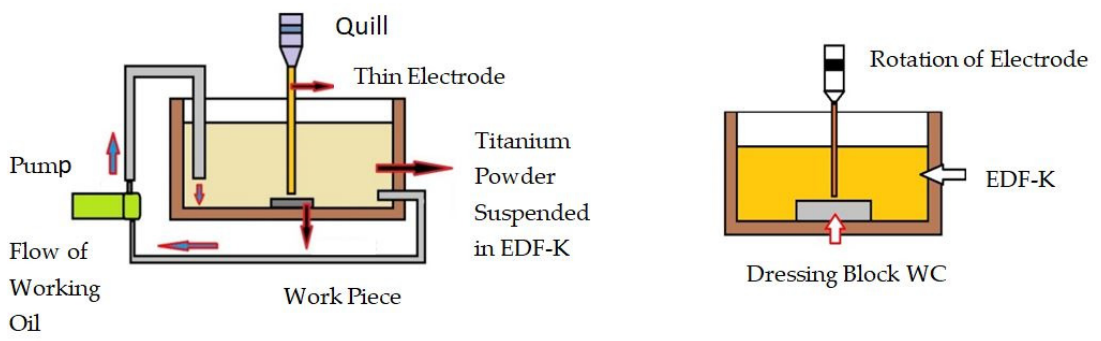
Figure 6. Experimental setup for accretion mechanism.